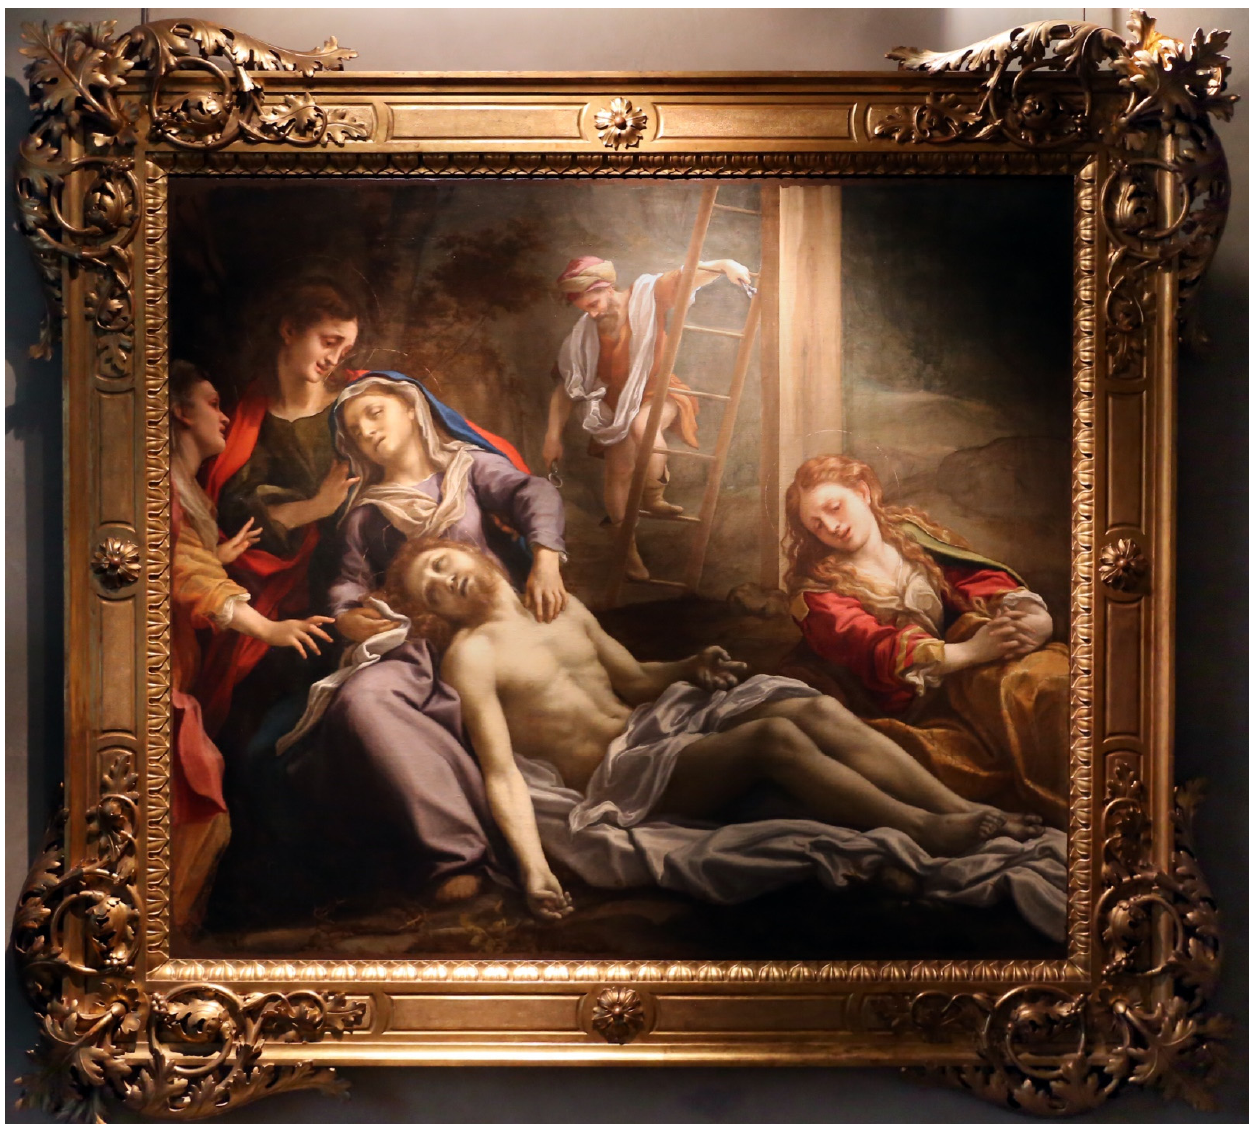
Figure 3. Correggio, Lamentation , 1524. Oil on canvas. Galleria Nazionale, Parma, Italy. Image Courtesy of Galleria Nazionale, Parma, Italy; https://museum.org/museum/Galleria-nazionale-di-Parma/ (accessed on 20 June 2021).